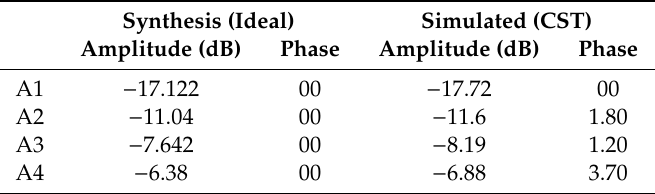
Table 2. Excitation coe ffi